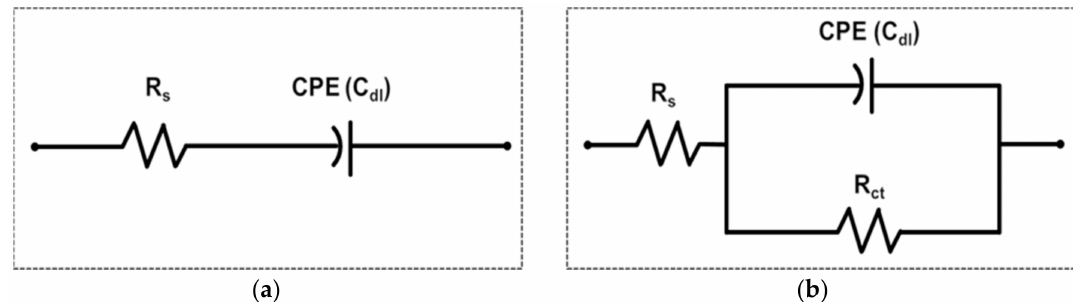
Figure 1. Equivalent circuit model of ( a ) non-faradaic spectroscopy and ( b ) faradaic spectroscopy. CPE (C dl ) is a constant phase element that represents a double layer capacitance, R s is a solution resistance and R ct is a charge transfer resistance,